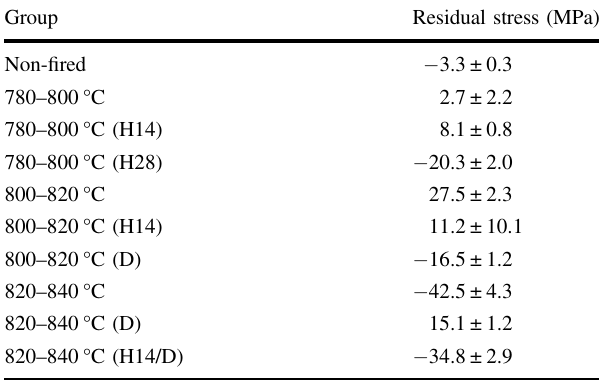
Data with “ − ” are index to compressive stress, Data without “ − ” are indicated to tensile